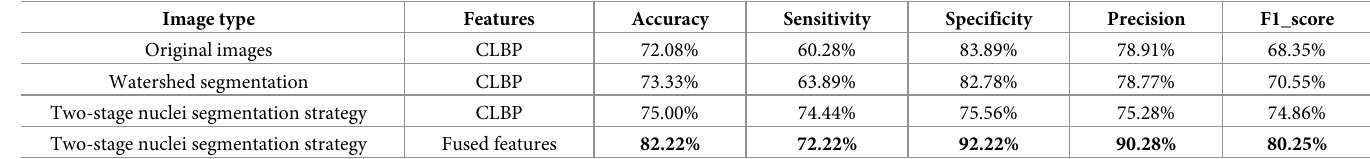
Table 5. Comparison of image segmentation results under different conditions at patch-wise.